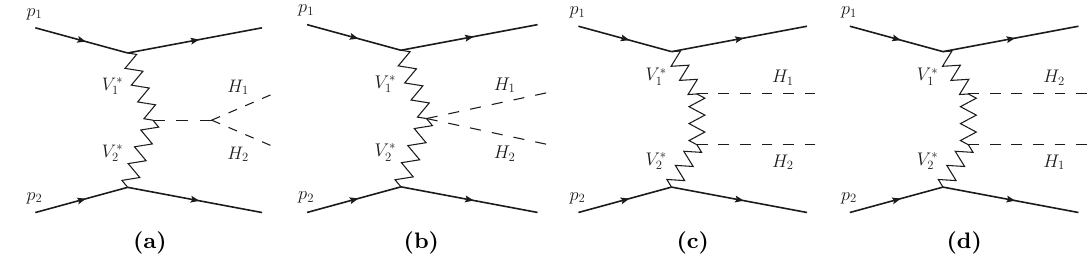
Figure 5. Diagrams for Higgs pair production. (a) The T 1 topology. (b) The T 2 topology. (c) The B 1 topology. (d) The B 2